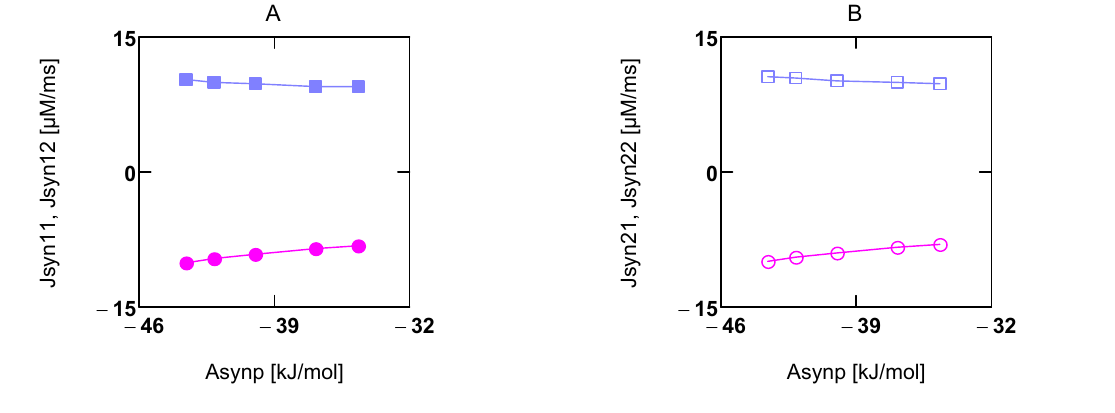
as a two-flux-system. p SY